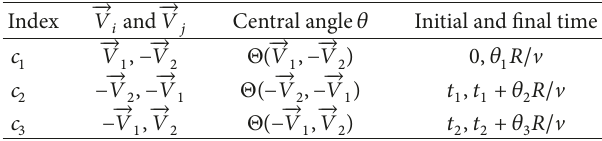
Table 2: Parameters of 𝑐 1 , 𝑐 2 , and 𝑐 3